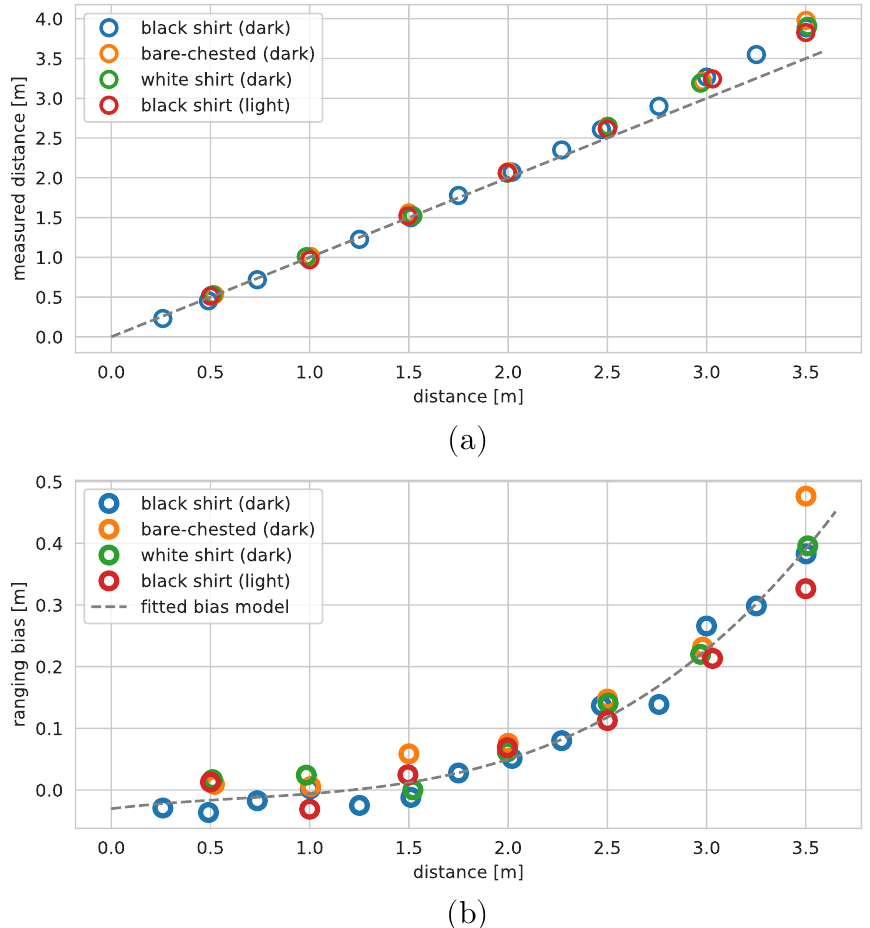
Figure 7. Ranging accuracy test results. ( a ) Distance measured from a person clad in different clothes. The grey dashed line is the actual distance drawn for reference. ( b ) Ranging bias. The coefficients of the fitted model are stored in Table